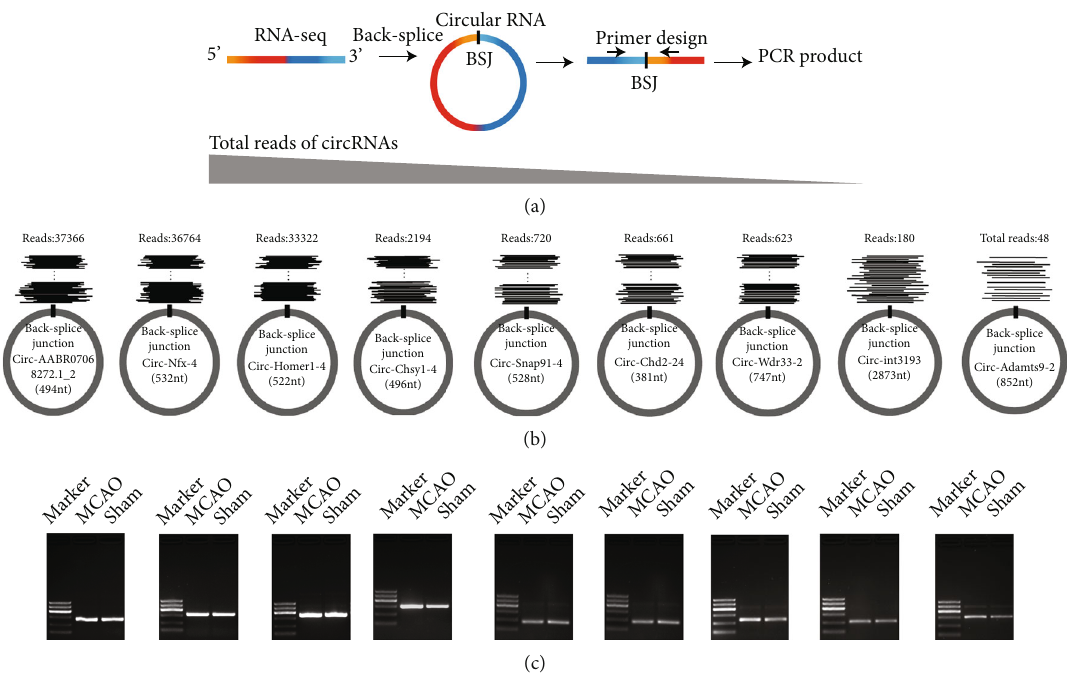
Figure 3: RT-PCR validation of selected circRNAs. (a) Schematic diagram of the circRNA validation strategy with divergent primers. (b) Nine novel representative circRNAs with decreasing supporting read counts. The long gray triangle represents the read expression level of circRNAs, and the supporting RNA-seq data of every read includes the back-splice site. (c) Identi fi cation of selected circRNAs through agarose gel electrophoresis of divergent ampli fi cation products. From upper to lower, the 100bp DNA ladder includes six fragments: 100, 200, 300, 400, 500, and 600bp. MCAO: cDNA templates derived from the MCAO group; Sham: cDNA templates derived from the sham control